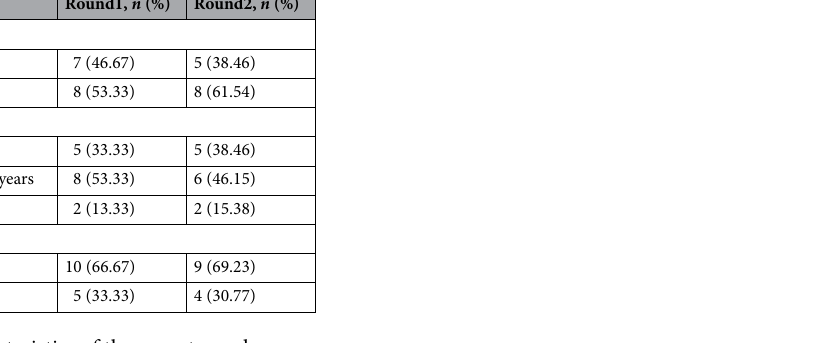
Table 3. Characteristics of the expert